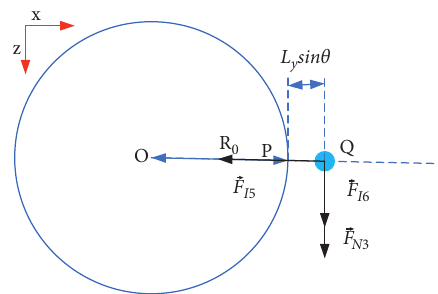
Figure 3: Force analysis of LSCM on the x - z plane.